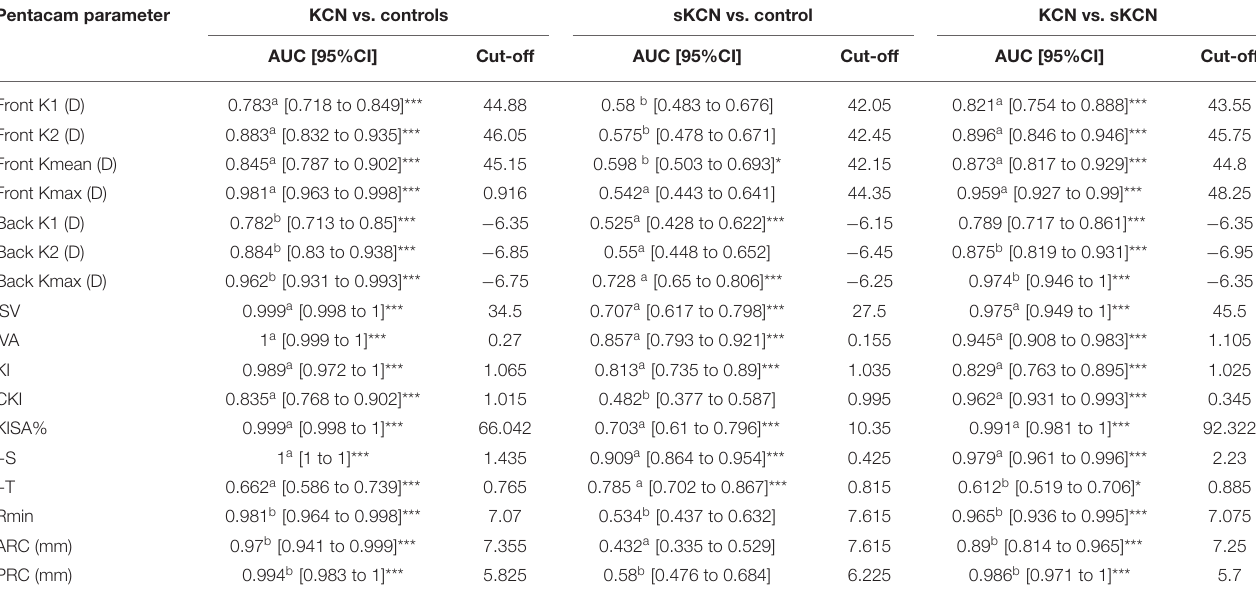
TABLE 5 | Curvature based Pentacam parameters AUCs and associated cut-off: KCN vs. controls, sKCN vs. controls, KCN vs. sKCN. Pentacam